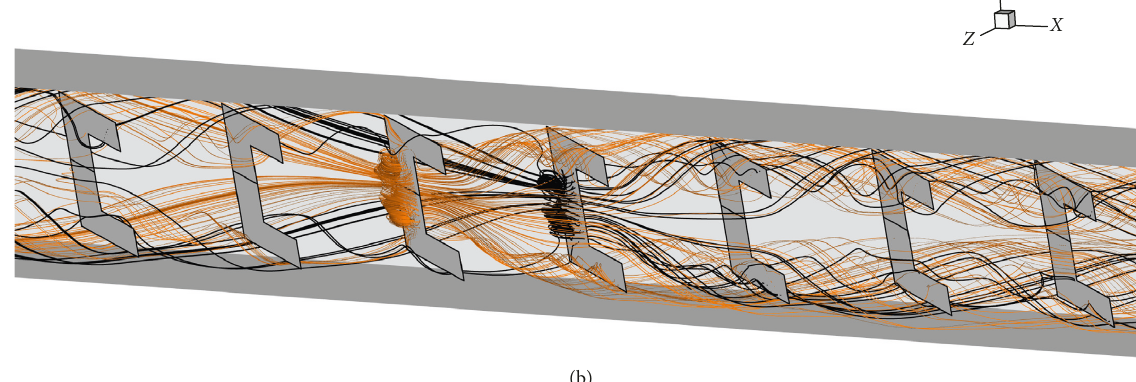
Figure 8: Longitudinal vortex flow for the square channel heat exchanger installed with V-orifice at (a) V-downstream and (b) V-upstream for b15g15 and Re 600. (cid:31)